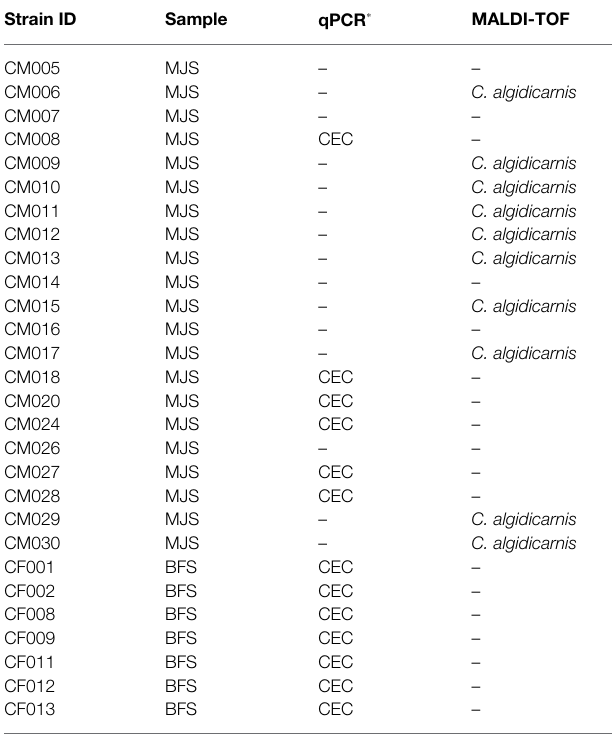
TABLE 1 | Presumptive identification of Clostridium estertheticum complex (CEC) and other Clostridium spp. strains isolated from meat juice samples (MJS) and bovine fecal samples